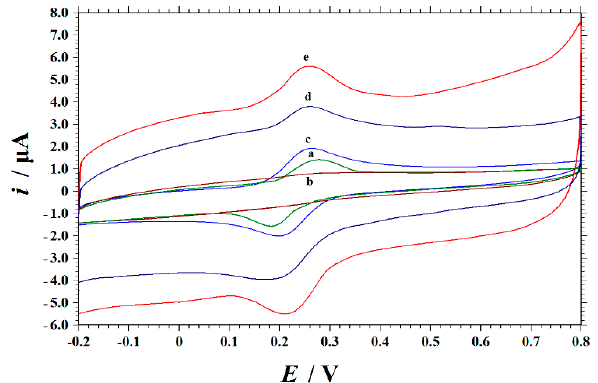
Figure 3. Cyclic voltammograms of glassy carbon electrode (GCE) ( a ), graphene oxide modified glassy carbon electrode (GO/GCE) ( b ), NH 2 -Fe 3 O 4 NPs-GO/GCE ( c ), ErGO/GCE ( d ), and NH 2 -Fe 3 O 4 NPs-ErGO/GCE ( e ) in 1.0 mmol/L K 3 [Fe(CN) 6 ] and 0.5 mol/L KCl with the scan rate of 0.1 V/s.